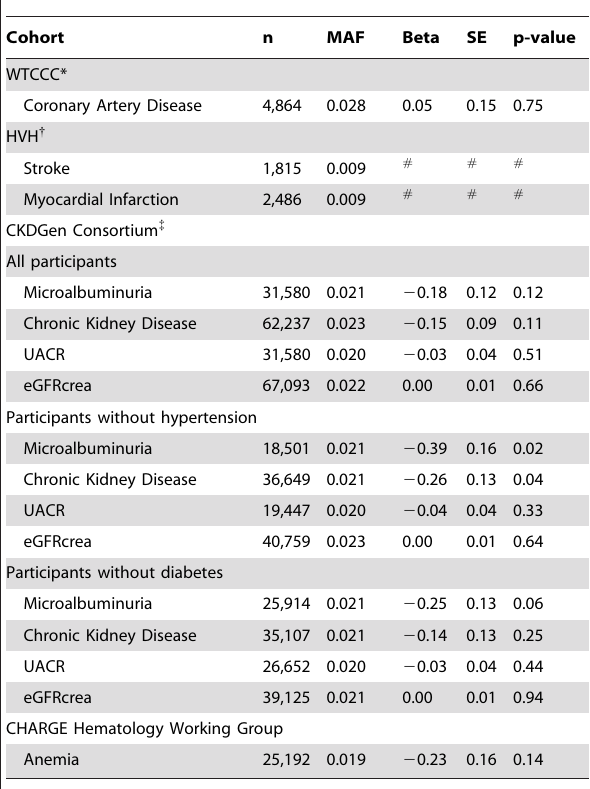
Table 3. The association between SNP rs12155400 on chromosome 7 and various micro- and macrovascular